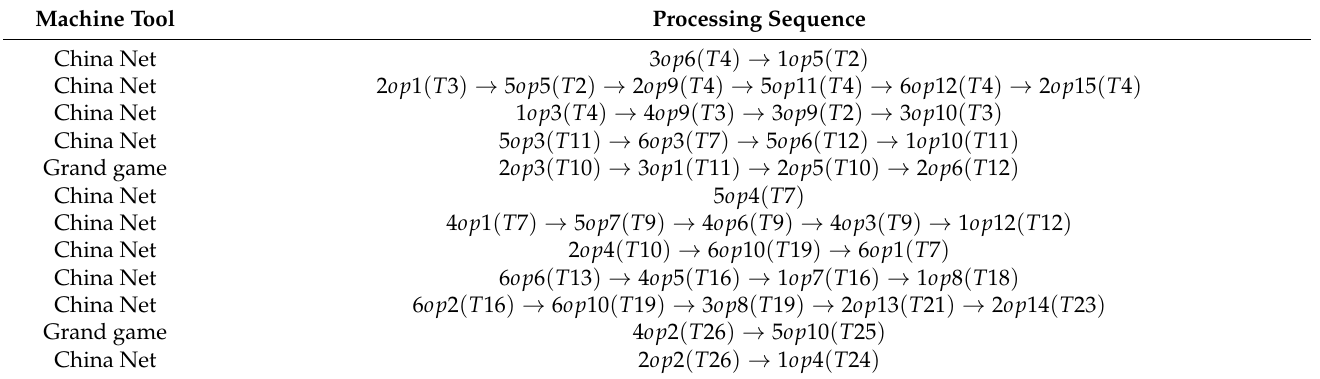
Table 8. Evaluation of process reconfiguration scheme based on TOPSIS evaluation method. Table 9. Process route arrangement based on Scheme 2.